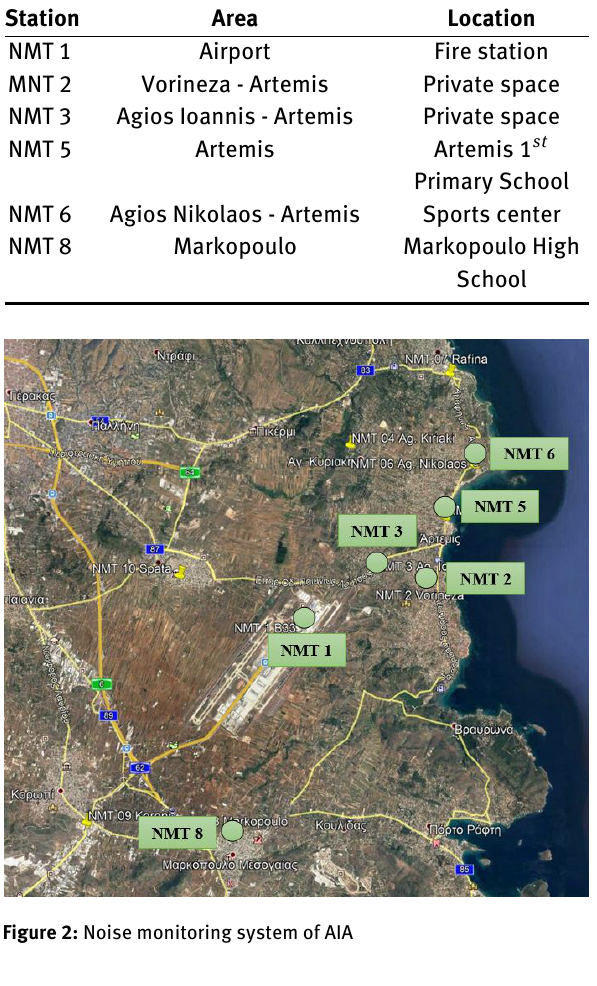
and the backbone of the urban and semi urban road